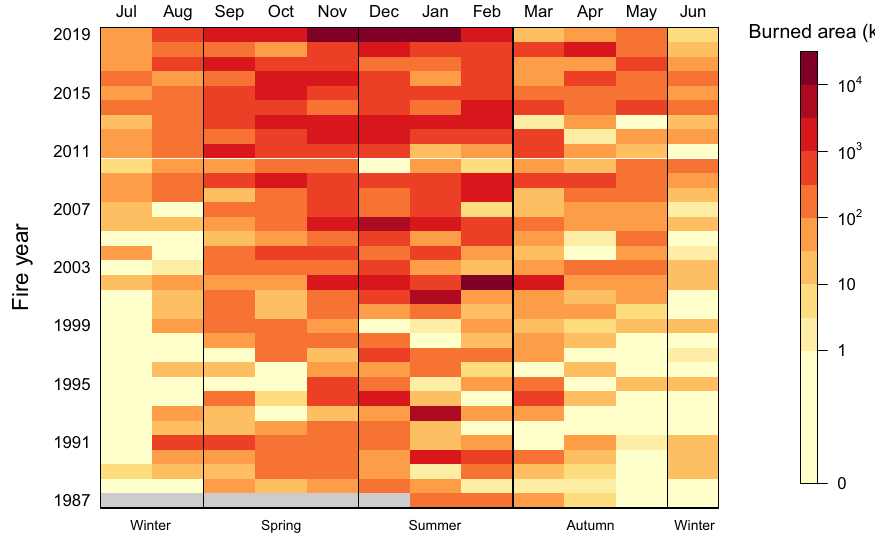
Fig. 2 Monthly burned forest area for fi re years (July to June). Data: AVHRR-Landgate (1988 – 2019).